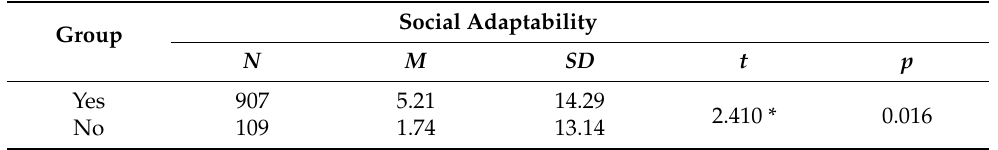
Table 8. Results of the difference in scores of social adaptability between the YES group and the NO